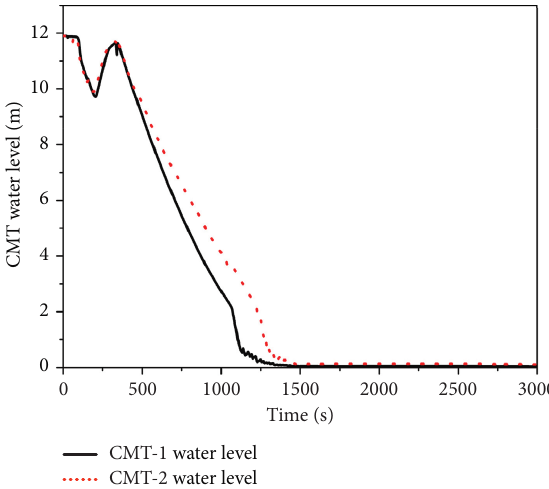
Figure 8: 10-inch CL break CMT water